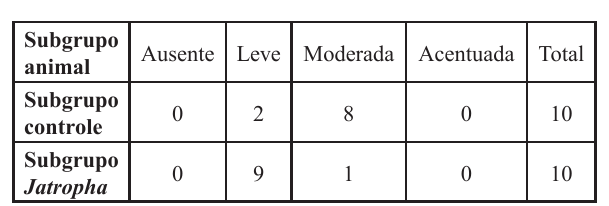
FIGURA 11 - Fotomicrografia com área de fibrose, notando-se deposição de colágeno (subgrupo Jatropha , coloração masson, aumento